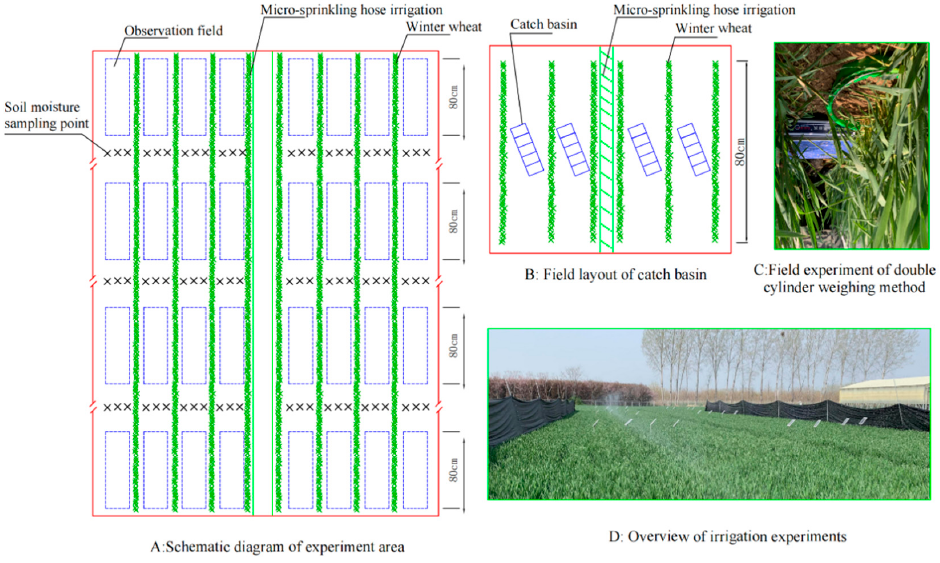
Figure 1. The layout of soil moisture distribution experiment in the second experimental year of 2021–2022.